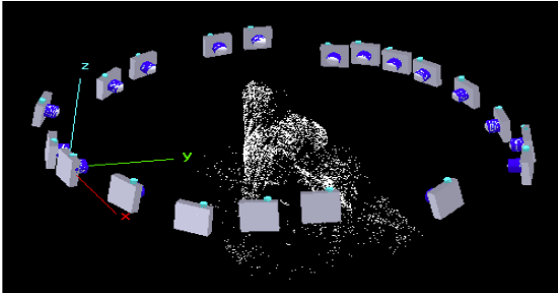
Figure 4. An example of closed image block simulation.